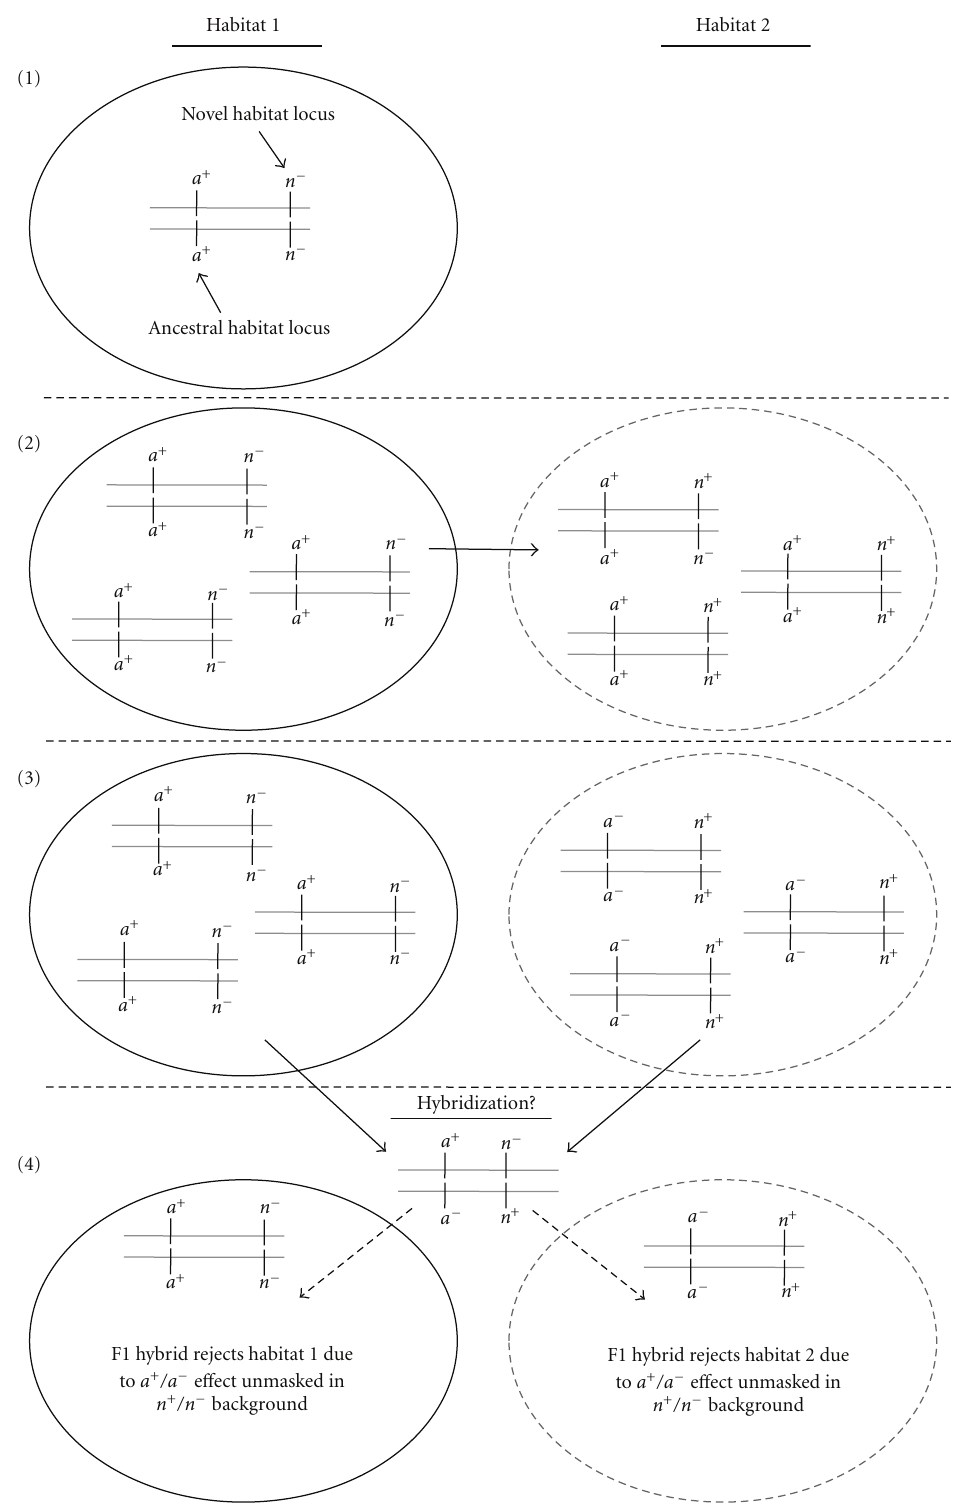
Figure 3: Illustration of model 3 based on epistasis between ancestral and novel habitat loci with preference and avoidance alleles. Numbered steps of model (1–4) are separated by dashed lines and ordered vertically. Individuals are represented by chromosome pairs as grey bars; ancestral (on left) and novel (on right) habitat loci are marked by two pairs of vertical black tick marks on grey chromosomes. Alleles at ancestral locus are labeled as follows: a + : preference for ancestral habitat; a − : avoidance for ancestral habitat. Alleles at novel locus are labeled as follows: n + : preference for novel habitat; n − : avoidance for novel habitat. Arrow depicts shift from ancestral habitat 1 to novel habitat